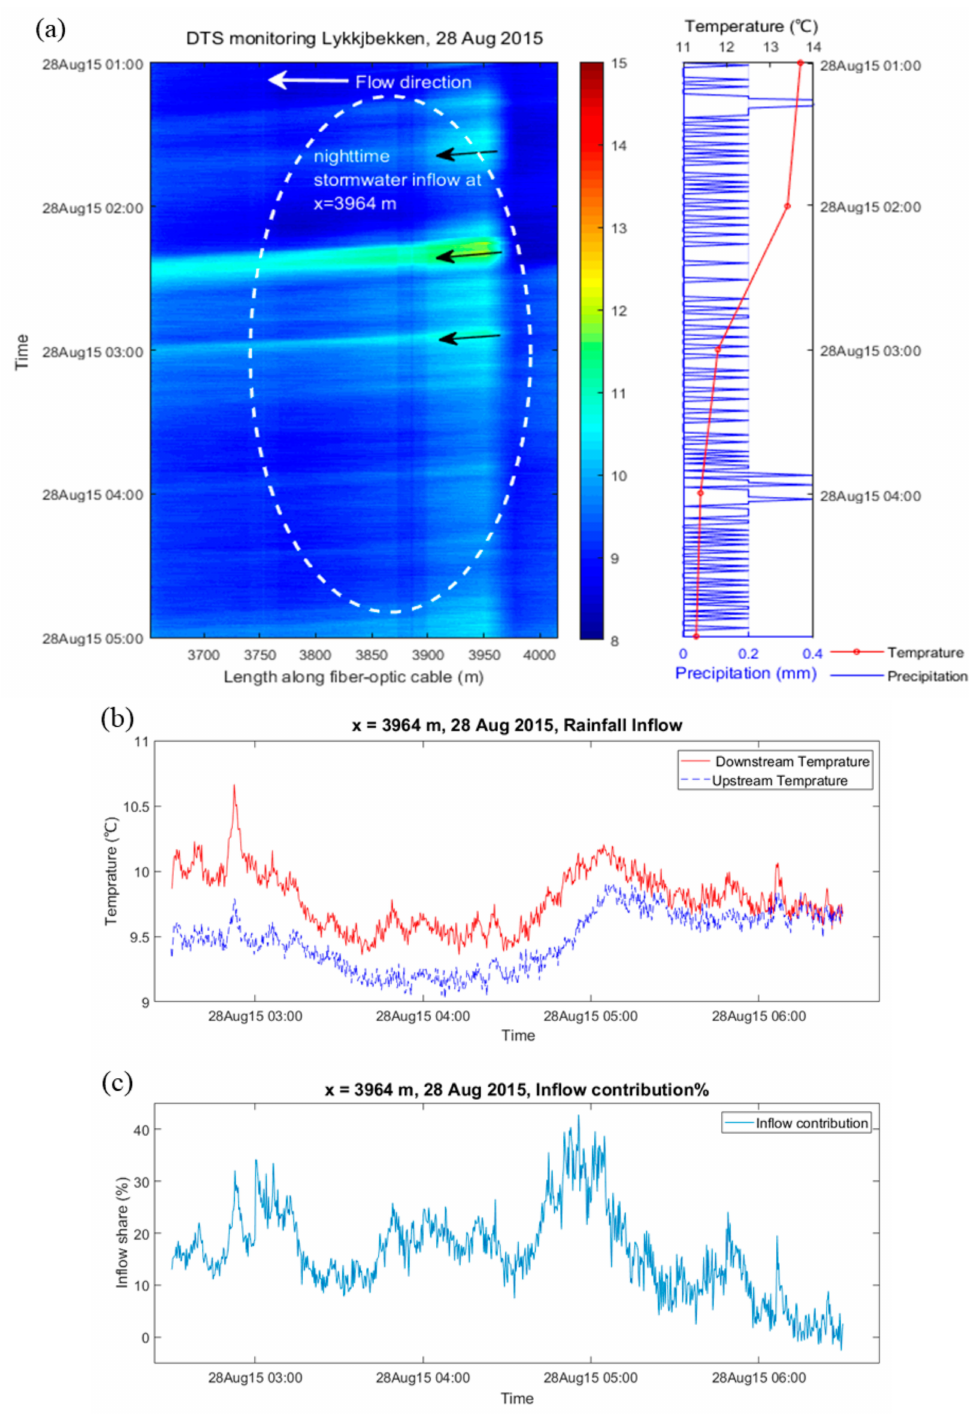
Figure 11. ( a ) DTS monitoring results around the rainfall-derived I/I point of x = 3964 m in storm event of 28 August, 2015; ( b ) the upstream and downstream temperatures around real stormwater infiltration at x = 3694 m; ( c ) percentage of I/I share in comparison with the upstream